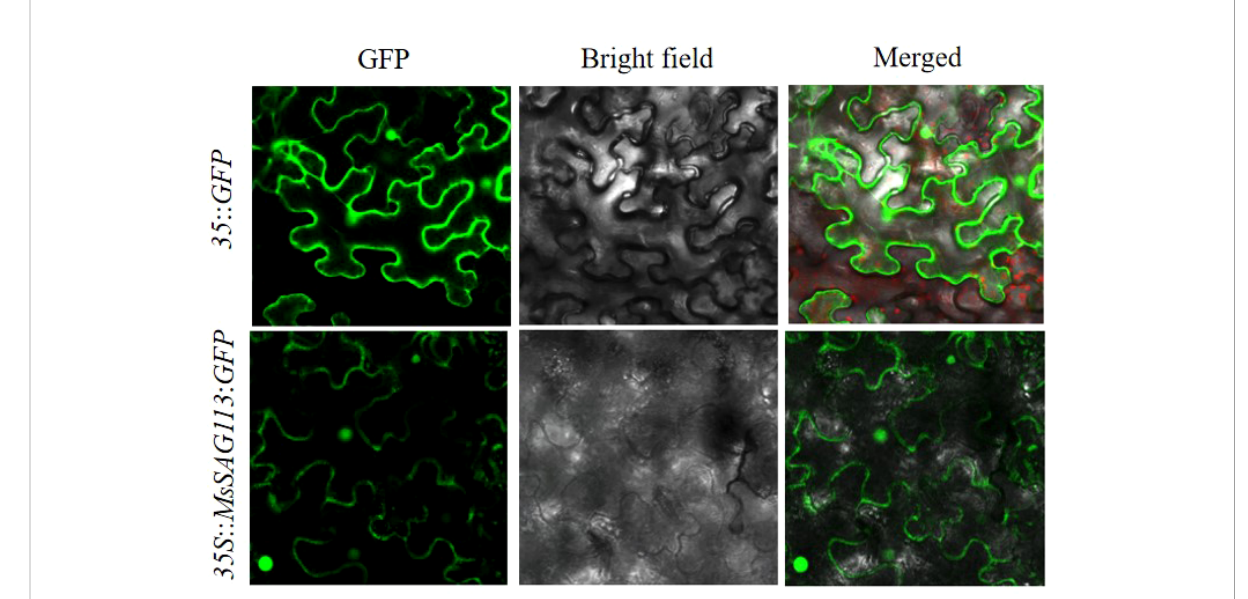
FIGURE 1 Subcellular localization of MsSAG113 in the nucleus and cytoplasm detected by GFP signal. Scale bars =25 m